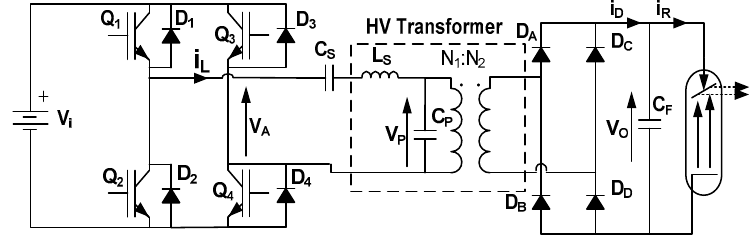
Figure 2. Series-parallel LCC resonant topology.